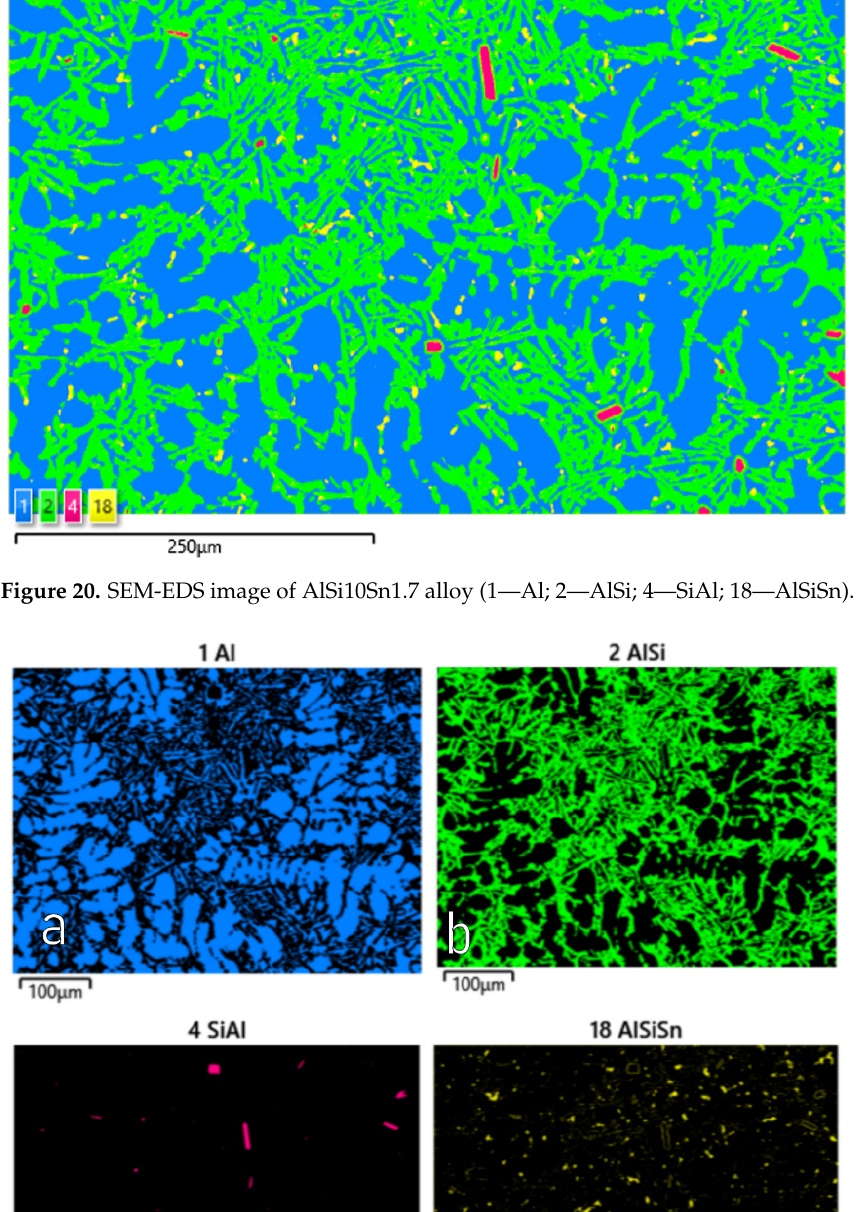
Figure 21. Phase distribution maps for AlSi10Sn1.7: ( a ) Al; ( b ) AlSi; ( c ) SiAl; ( d ) AlSiSn.